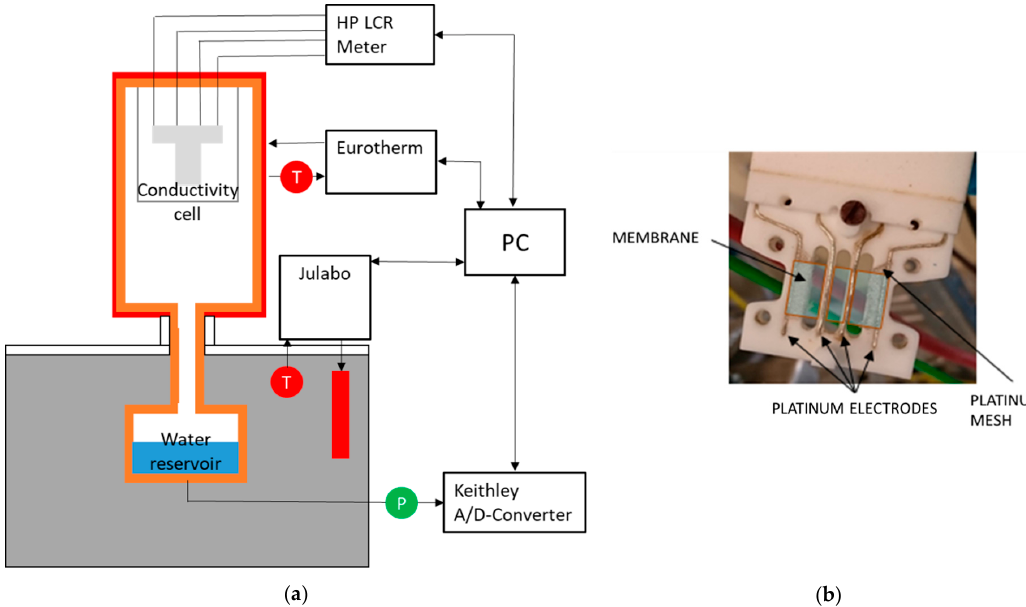
Figure 2. ( a ) Experimental arrangement and ( b ) in-plane measurement cell.